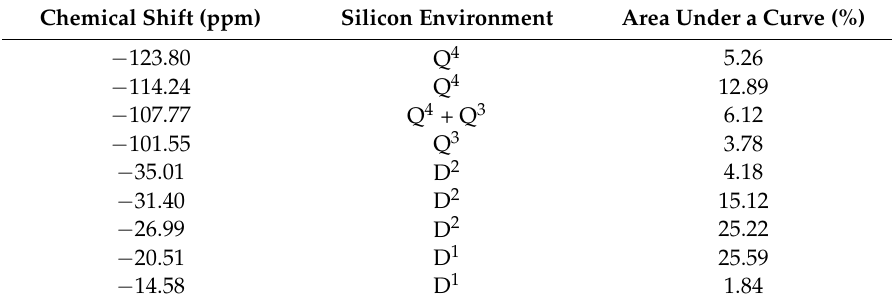
Table 2. Chemical shift and silicon environments of the HMMSN hybrid magnetic mesoporous nanorods.